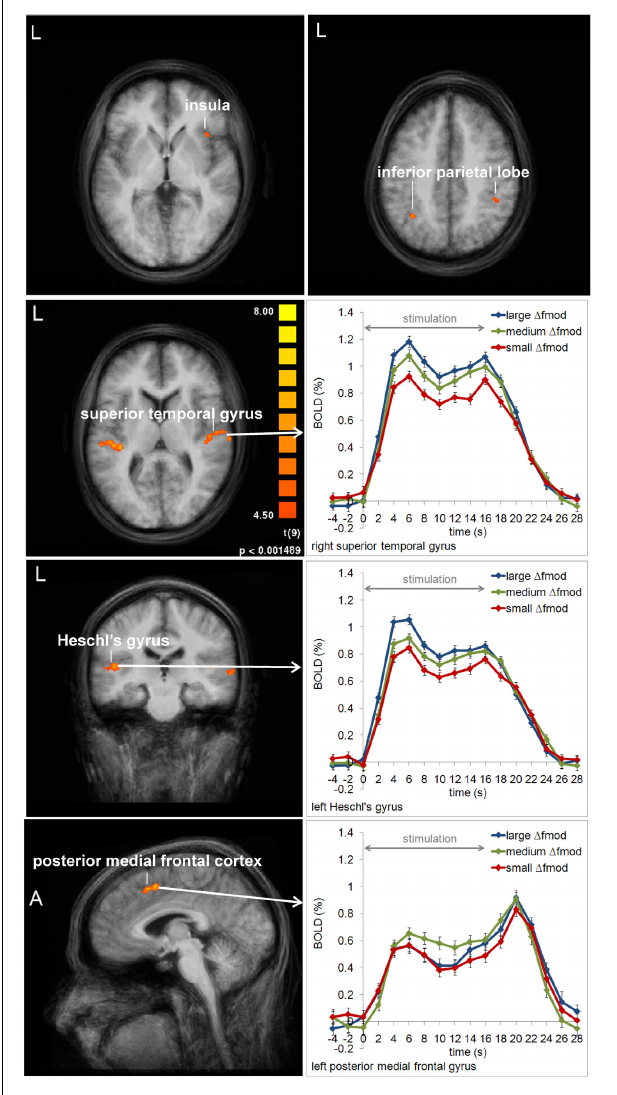
FIGURE 8 | Group average activation maps (10 subjects) and BOLD signal time courses within regions of interest in Experiment 2. The maps depict all brain regions with positive deflections of the BOLD response in at least one of the three (cid:2) f mod conditions compared to the baseline ( t = 4 . 5, p < 0 . 002) for each f c (1, 4kHz). Several regions that showed significant differences between conditions are labeled and the respective averaged BOLD signal time courses are assigned. Error bars represent